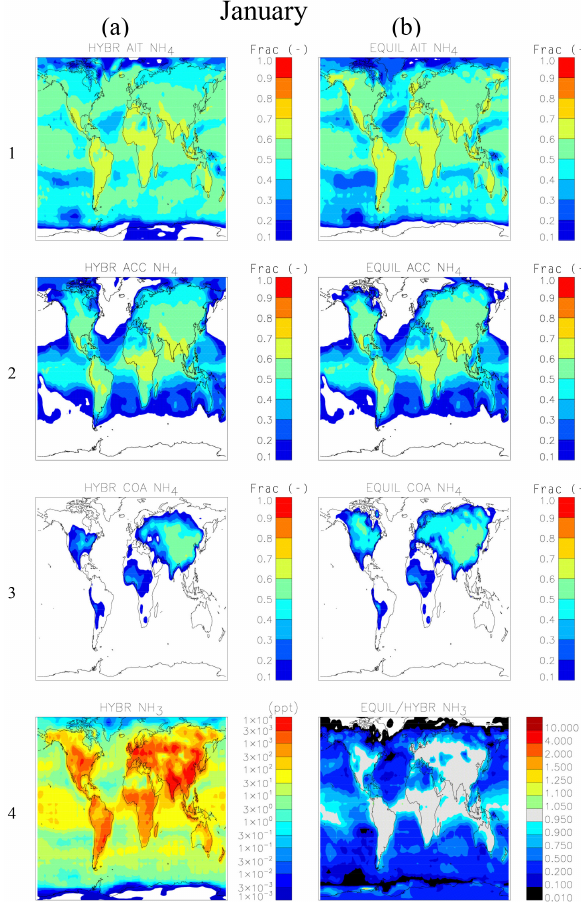
Figure 16. Same as Fig. 14 for January 2004. Figure 17. Same as Fig. 15 for January